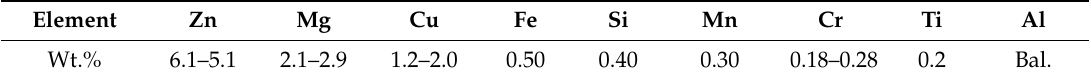
Table 1. Nominal chemical composition of AA7075-T6 [20].